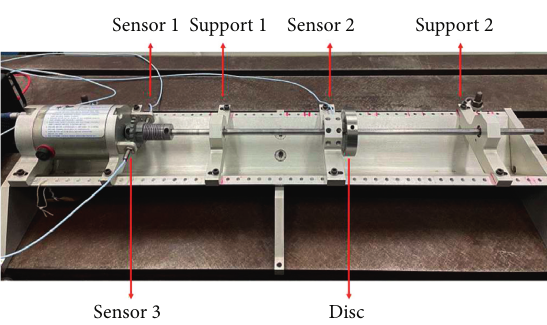
Figure 12: The test rig of the single disc rotor